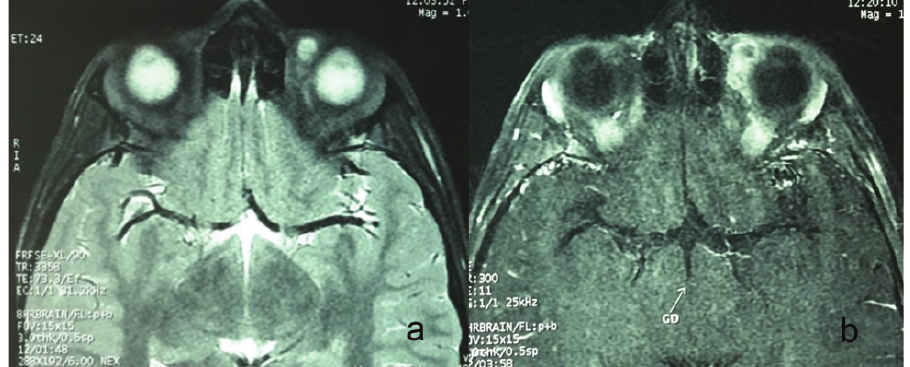
Figure 2. Orbital MRI. (a) Axial T2-weighted image shows a lesion in superior-medial part of left orbit with thick surrounding low signal and central high signal intensity, stranding inside the lesion that is compatible with nematodes (orange arrow). (b) Axial T1-weighted images after iv contrast injection shows marked enhancement in the